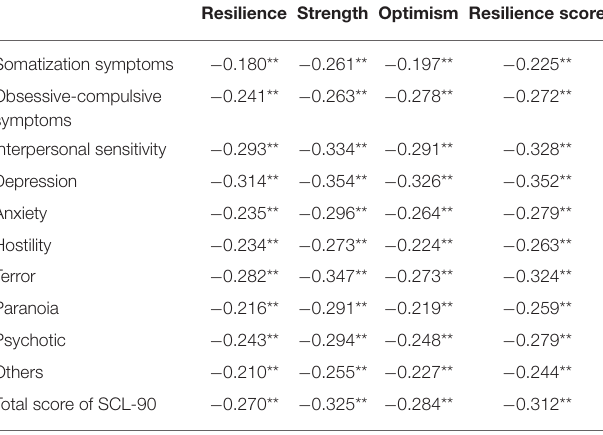
TABLE 5 | The scores of psychological resilience between SFD and non-SFD. TABLE 3 | Correlation between mental health and psychological resilience of SFD. Resilience Strength Optimism Resilience score SFD N Mean Std.